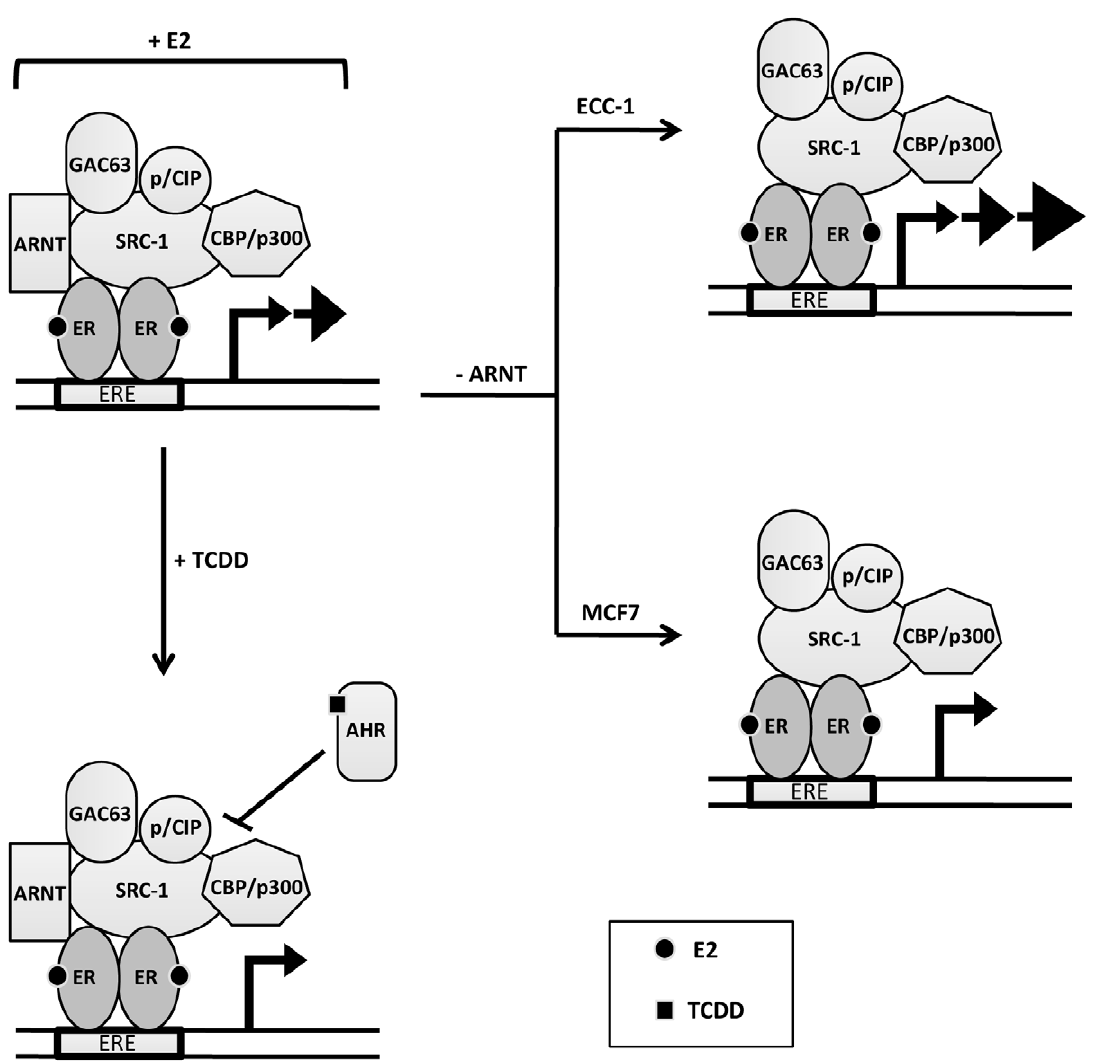
Figure 6. A schematic representation of estrogen signaling, describing the transcriptional functions of ER, AHR and ARNT in ECC-1 and MCF7 cells. The presence of E2 facilitates the assembly of transcriptional modifiers that induce transcription of E2-responsive genes. Ligand activated AHR represses ER-signaling independent of ARNT. The loss of ARNT in ECC-1 cells, where it acts as a co-repressor, leads to increased sensitivity to E2 and increased transcriptional activity at ER regulated genes. The loss of ARNT in MCF7 cells, where it acts as a co-activator, leads to decreased sensitivity to E2 and decreases transcriptional activity at ER regulated genes.